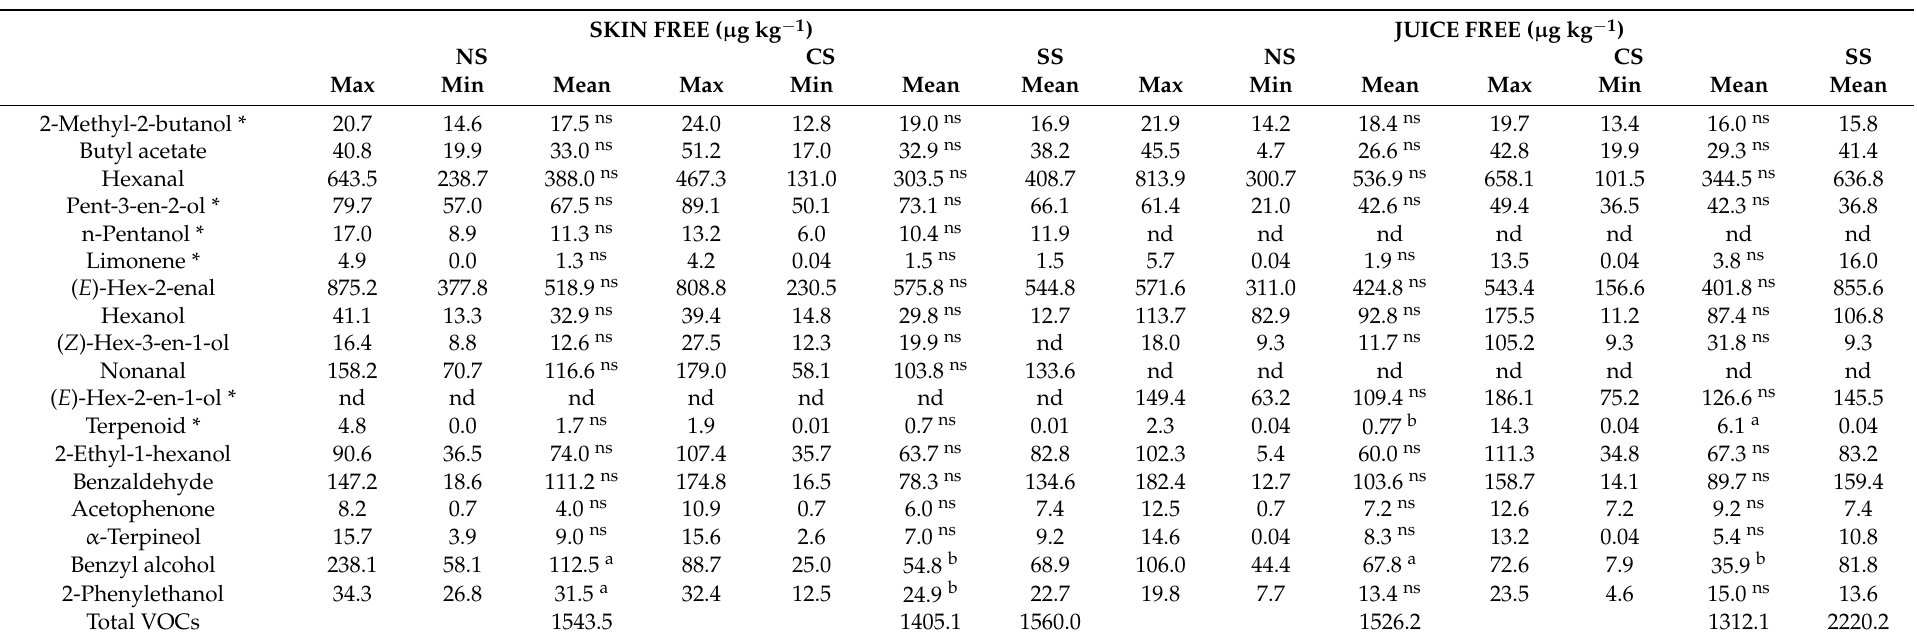
Table 3. Range and average levels of volatile-free aroma compounds in the skin and pulp of Cannonau grapes collected in